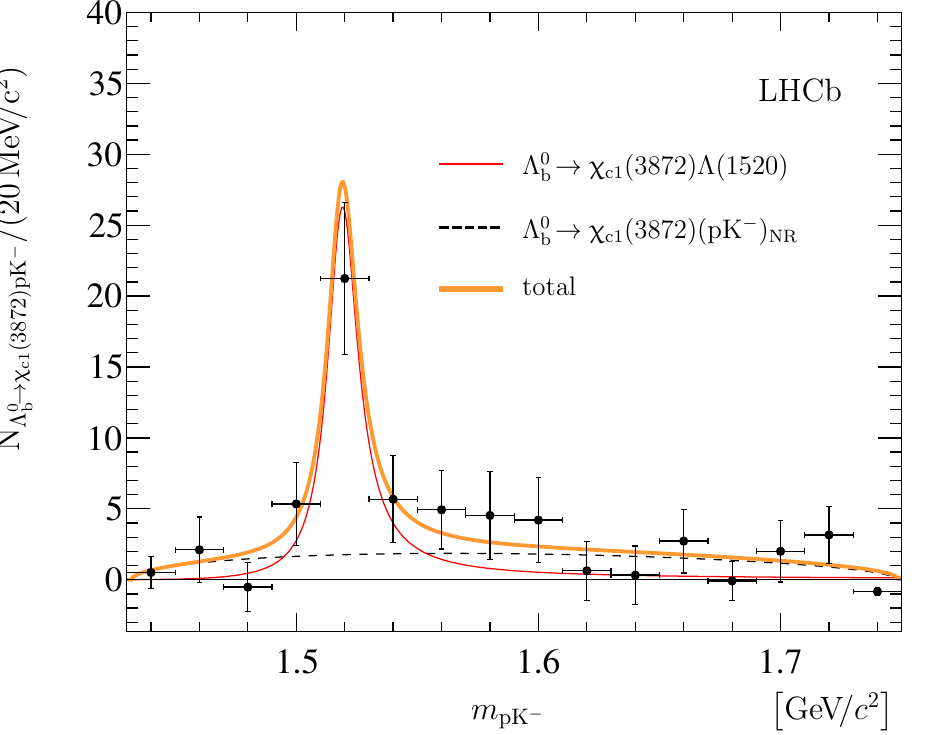
! (cid:31) c1 (3872)pK (cid:0) de- b < 1 : 75 GeV/ c 2 superimposed. The background sub- pK (cid:0)